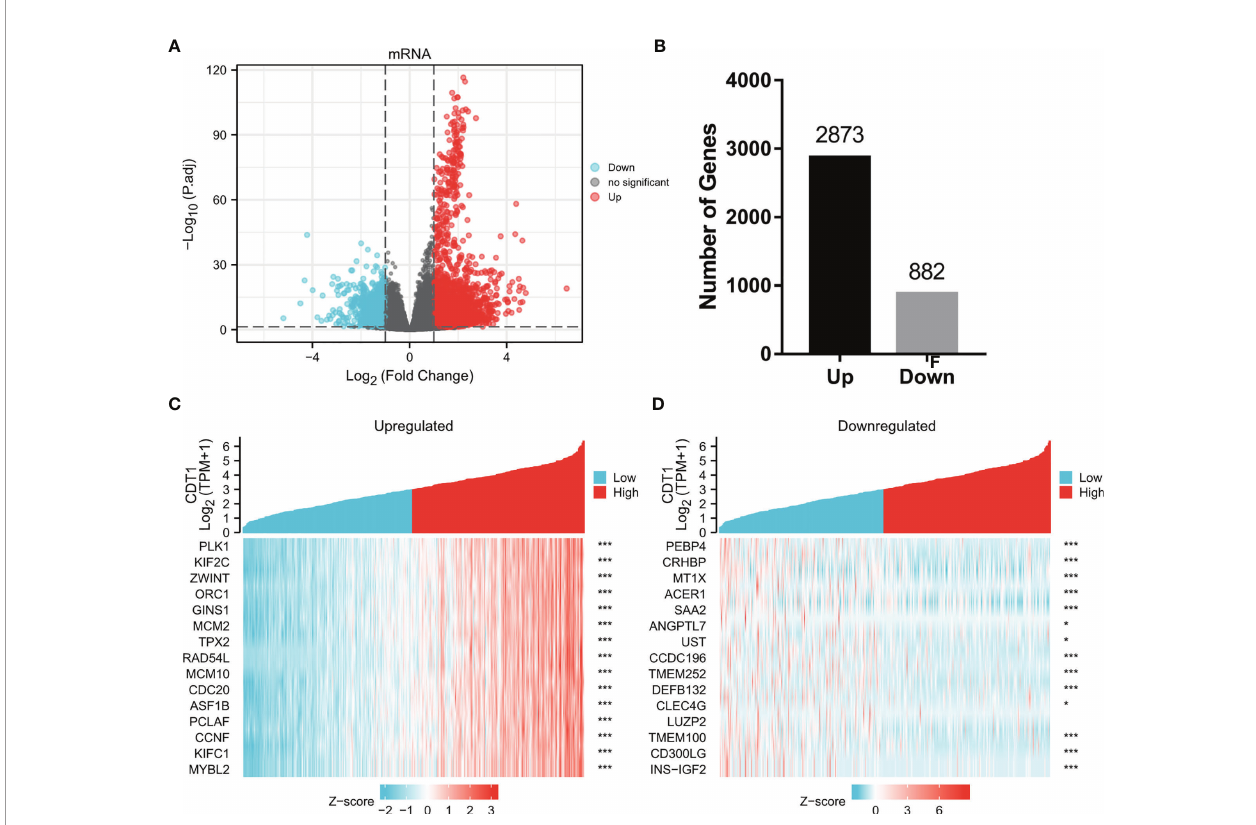
FIGURE 6 | Volcano plots and heatmap plots of DEGs between the expression of CDT1 high and CDT1 low in HCC samples. (A) The volcano plot described 3755 DEGs (|log2fold change| > 1 and adjusted p -value < 0.05). (B) The histogram showing the number of up-regulated or down-regulated genes. (C, D) The heatmaps depicted the expression of 15 signi fi cant upregulated and downregulated genes in HCC samples with CDT1 high and CDT1 low expression. * p < 0.05, *** p <